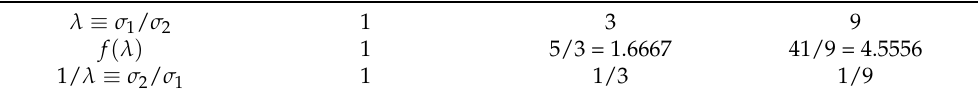
Table 1. Since the aircraft dissimilarity function (33b) is unchanged by interchanging the two aircraft, the three values in (33a) apply to six values of the dissimilarity parameter